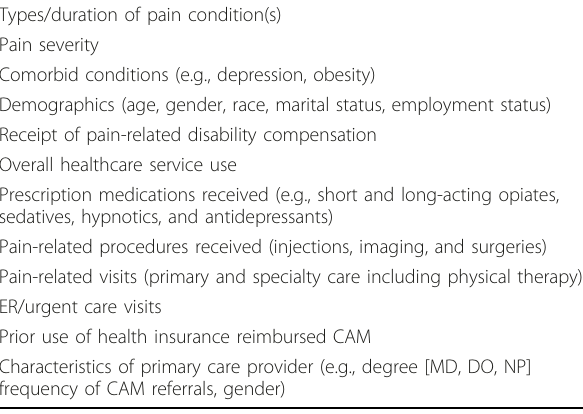
Table 3 Phase 1: Variables available from EMR for Clustering/Matching